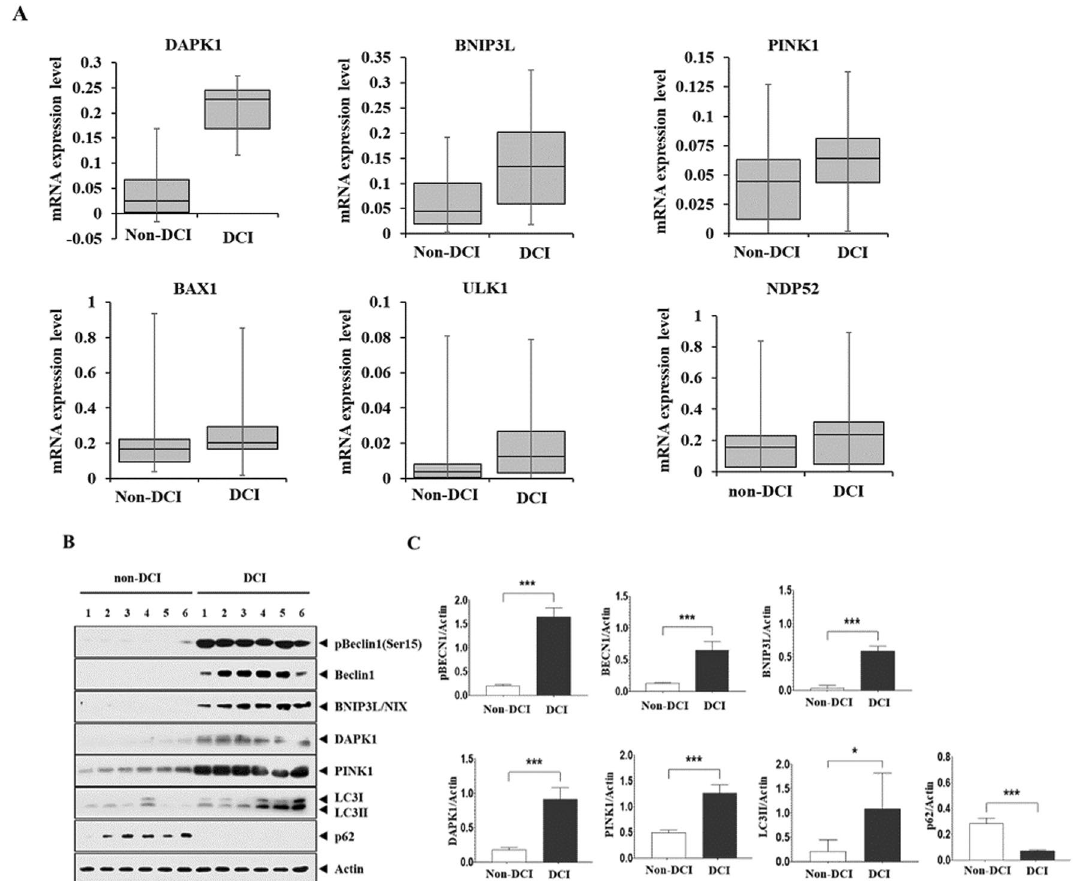
Figure 2. Analysis of autophagy and mitophagy markers expressed in CSF cells of SAH patients. ( A ) qRT-PCR revealed that SAH patients with DCI exhibited increased mRNA expression of DAPK1, BNIP3L, and PINK1 compared with those without DCI. Differences in mRNA expression of BAX, ULK1, and NDP52 did not reach statistical significance between the two groups. ( B , C ) Western blot analysis and quantification of blots using relative optical densities. Increased expression of BECN protein and phosphorylation at Ser15. LC3II expression with p62 degradation was observed in SAH patients with DCI. Actin was used as the loading control. The error bars represent SEM. *, **, and *** represent p value of less than of < 0.05, 0.01, and 0.001,